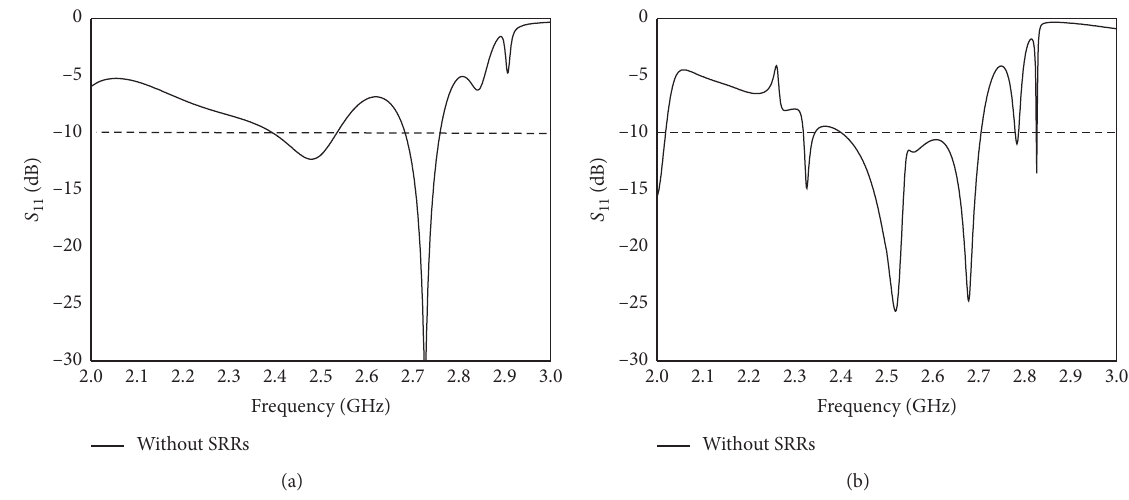
Figure 2: S11 of reference antenna array. (a) Inverse balun. (b) Directional